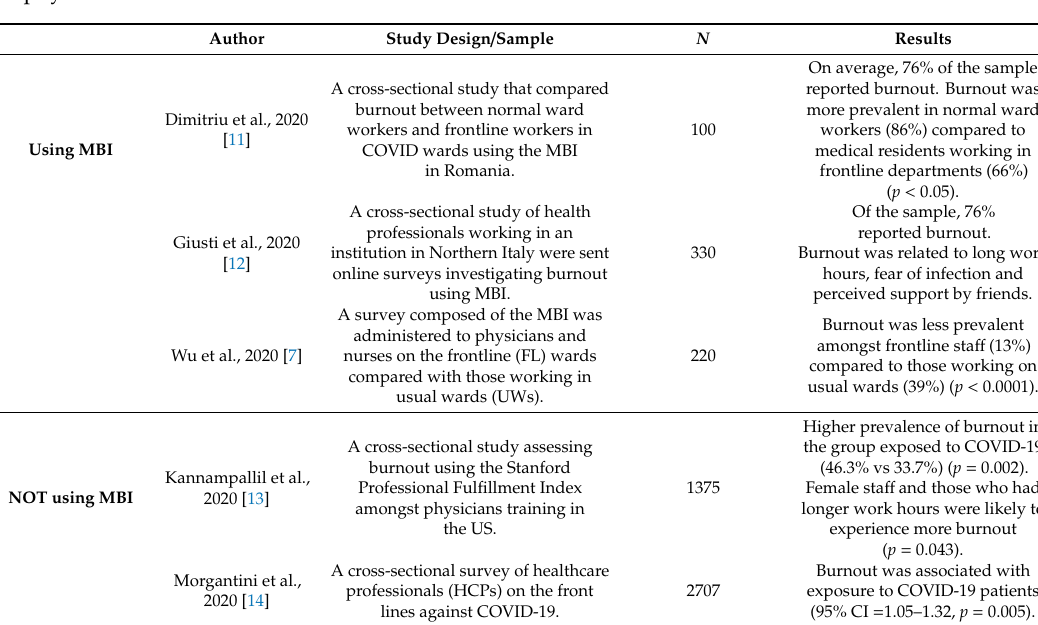
Figure 1. Flow diagram of selection process. Table 2. Methodological characteristics and the main results for studies on the impact of COVID-19 on physician